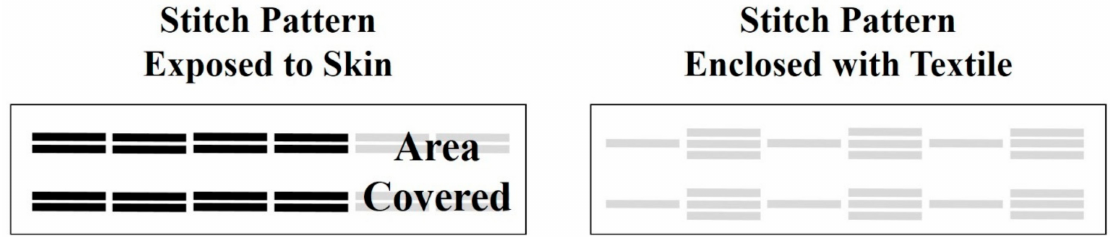
Figure 1. Stitch patterns for e-textile electrodermal activity (EDA) electrodes, where each e-textile electrode exposed to the surface of the skin covers 0.12 cm 2 of surface